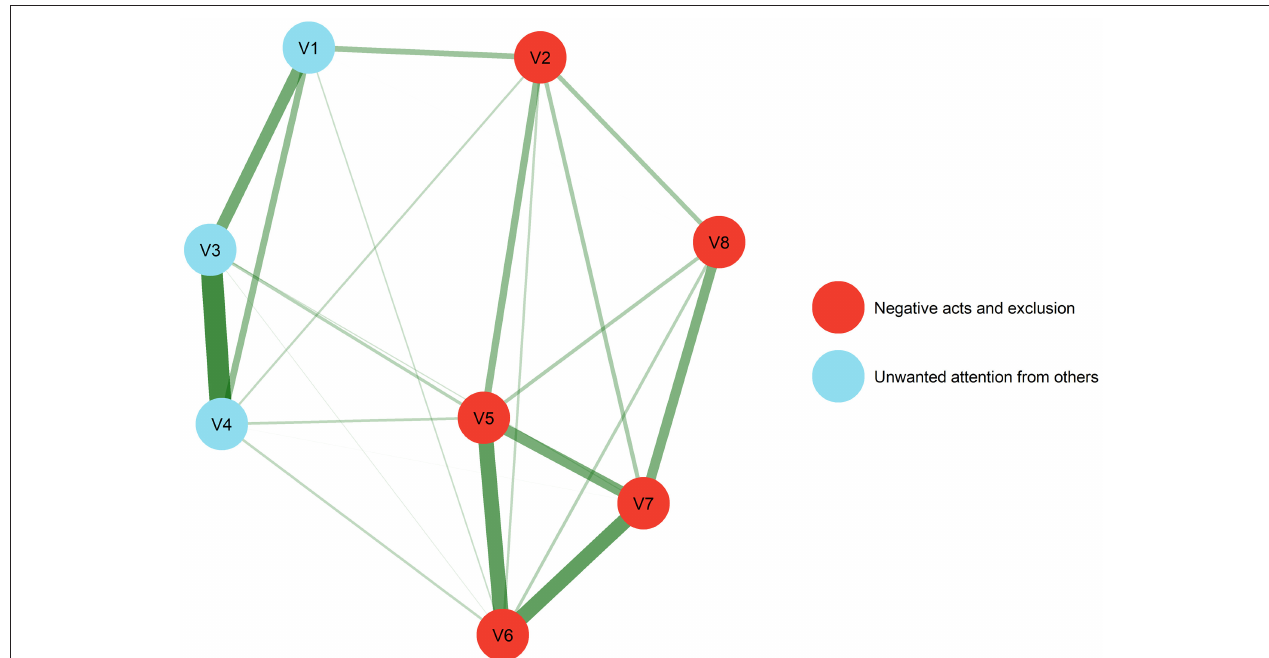
FIGURE 1 | Results from exploratory graph analysis. Unwanted attention from strangers (V1) Others share pictures/videos (V2) Receive unwanted nude pictures/sexualised content (V3) Asked to send nude pictures/sexualised content (V4) Negative comments (V5) Unpleasant/hurtful messages (V6) Negative talk from others (V7) Excluded from groups/chats